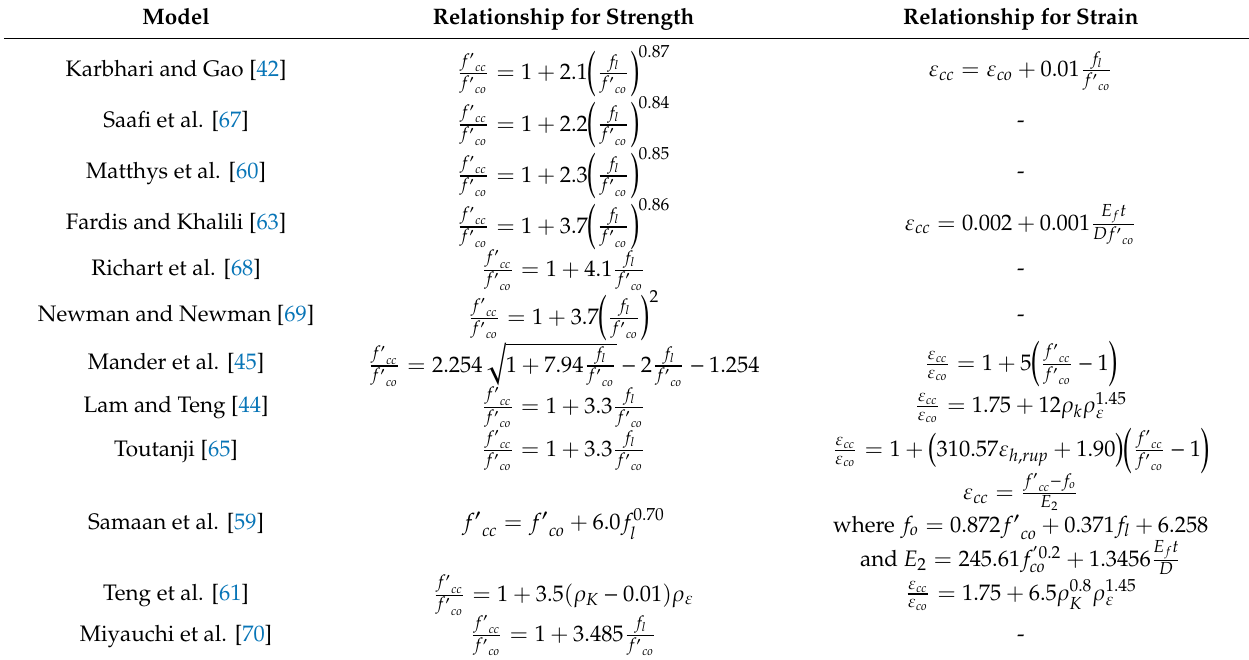
Table 1. Previously proposed strength and strain models of fiber-reinforced polymers (FRP) confined concrete